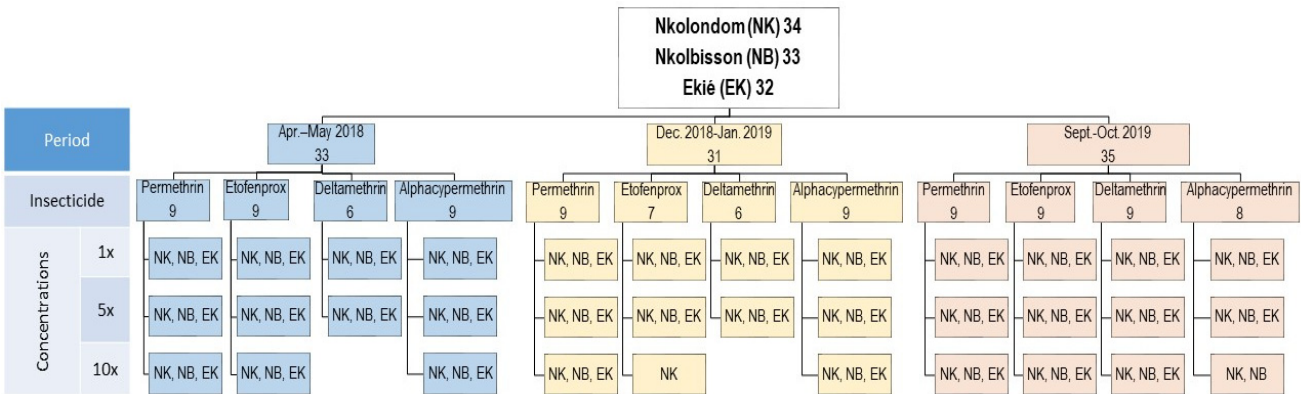
Figure 2. Study design showing resistance incidence and resistance intensity assays carried out with field-collected Anoheles gambiae s.l. samples throughout the two-year study period (2018–2019). (Apr.–May 2018: April–May 2018; Dec. 2018–Jan.